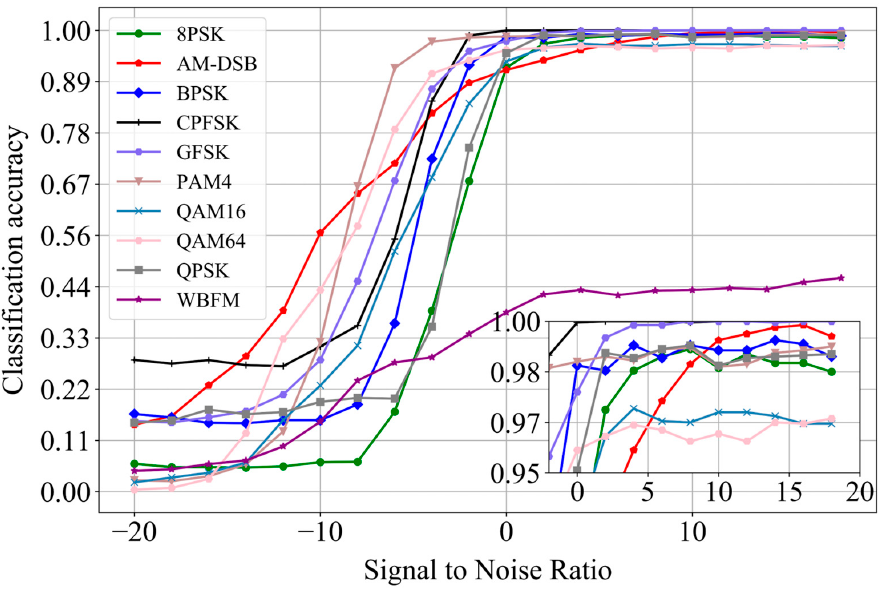
Figure 4. Recognition accuracy of ten modulation signals with different SNRs.